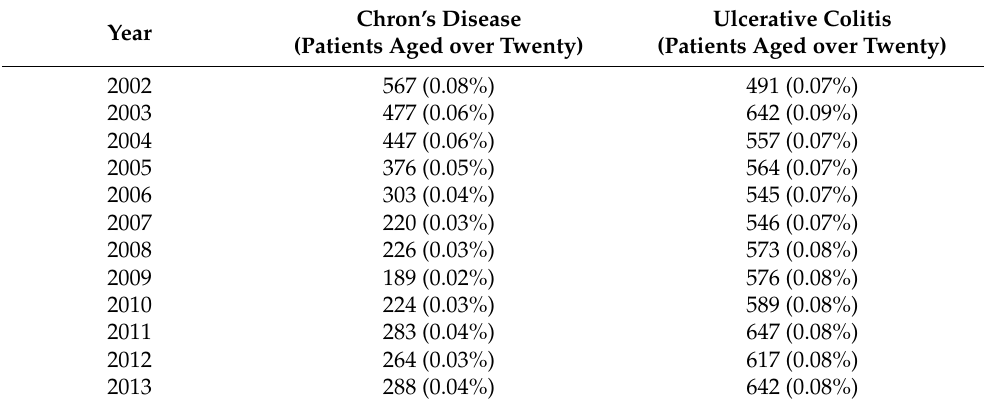
Table 6. Prevalence of Crohn’s disease and ulcerative colitis according to the year (from 2002 to 2013). Chron’s Disease Ulcerative Colitis Year (Patients Aged over Twenty) (Patients Aged over